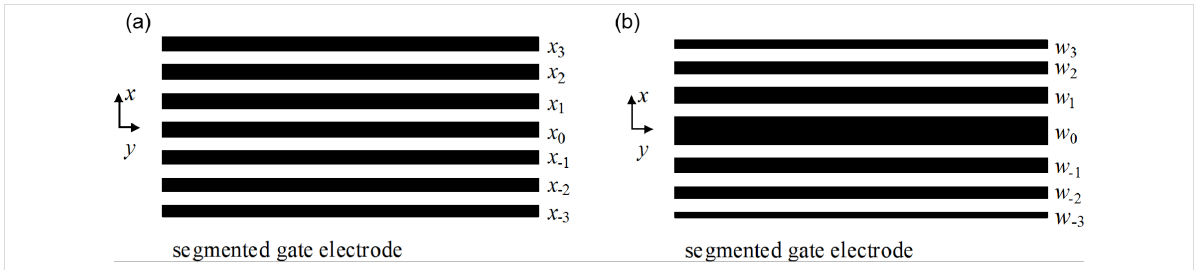
Figure 2: Schematic representation of a segmented gate electrode with segments with (a) equal and (b) unequal